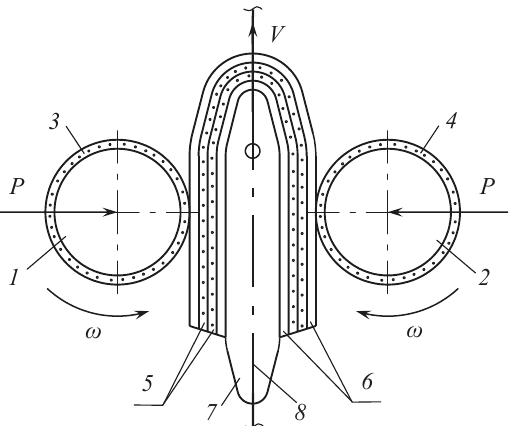
Figure 3. Schematic of wet leather semi-finished products fed to the extraction zone. 1, 2—compression rolls, 3, 4, 5—moisture-removing materials, 6—leather semi-finished products, 7—base plate, 8—drag chain.